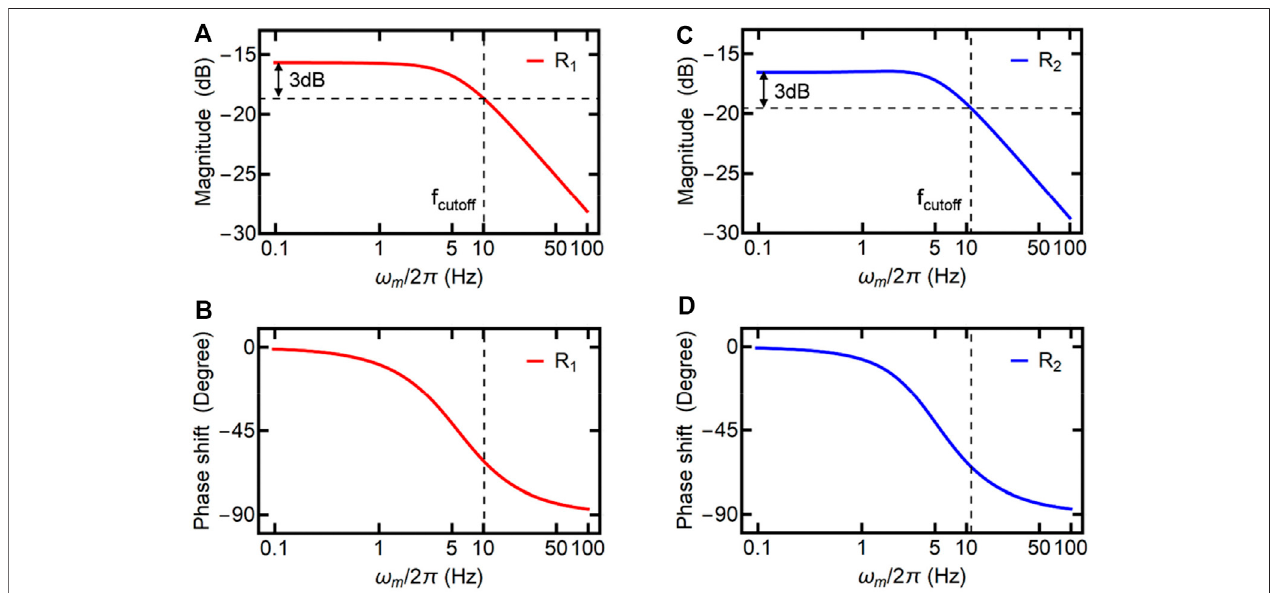
FIGURE 2 | (A) The magnitude and (B) the phase shift of the response function R 1 as a function of ω m . (C) The magnitude and (D) the phase shift of the response function R 2 as a function of ω m . The dashed lines are used to indicate the cutoff frequency. The parameters for the theoretical simulations are Λ = ‒ 2 π ×1 Hz, γ 1 = 2 π ×6 Hz, and γ 2 = 2 π ×12 Hz.